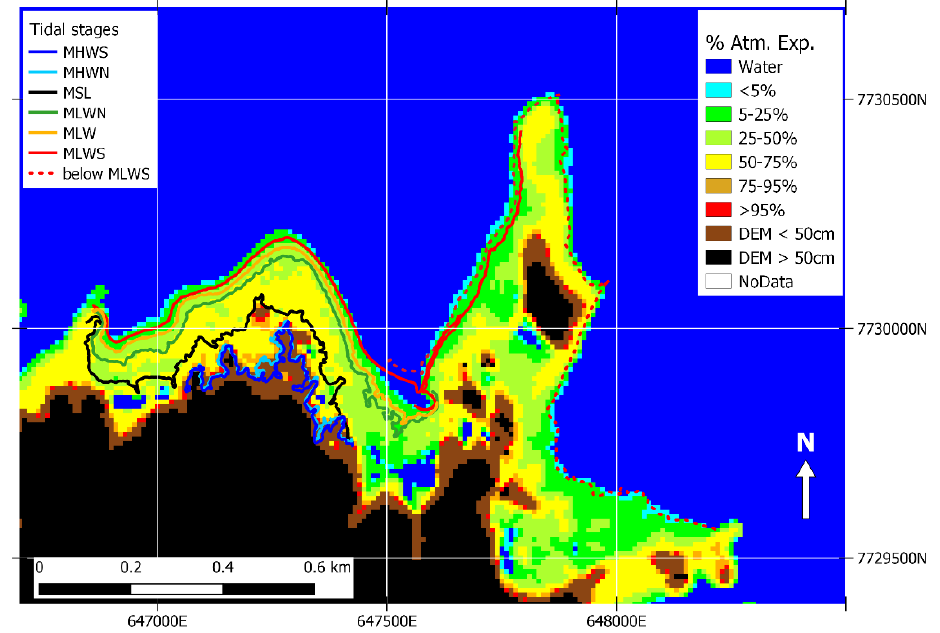
Figure 14. Different tidal water level lines superimposed on the ITZ atmospheric exposure product in Lille Grindøy, Troms.